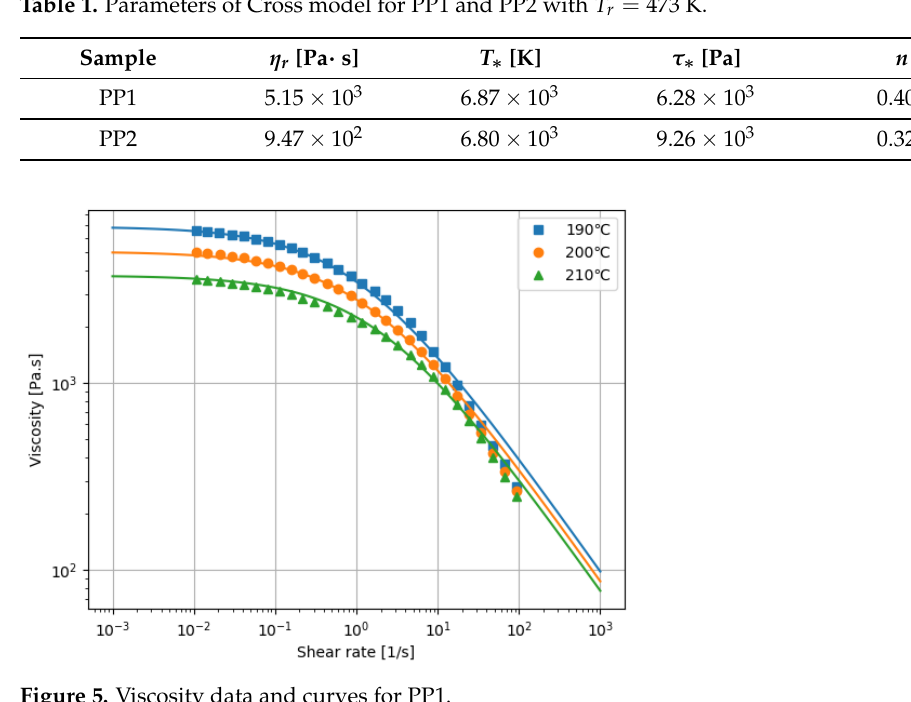
Figure 5. Viscosity data and curves for